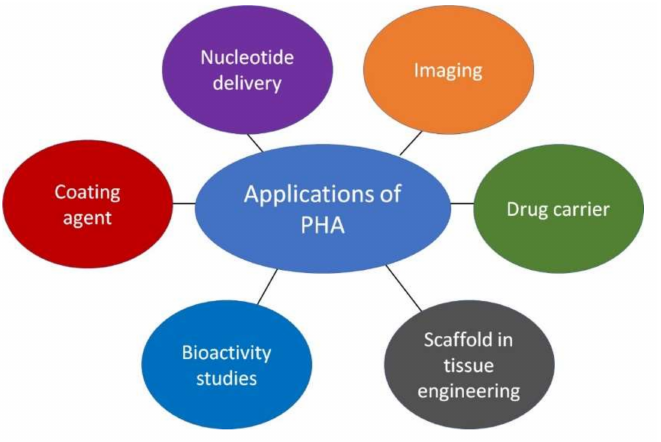
Figure 4. Applications of